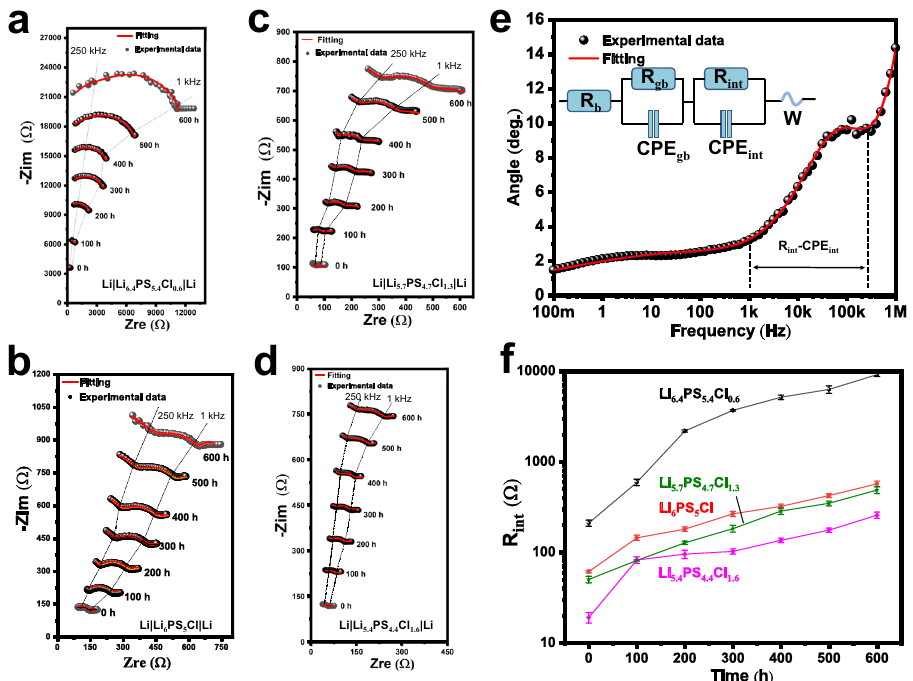
Fig. 2 Time-resolved EIS tested intermittently on the Li|Li 7 − x PS 6 − x Cl x |Li symmetric cells for 600 h at 24 °C. Evolution of the impedance signal in Nyquist plots for the samples of Cl-06 ( a ), Cl-10 ( b ), Cl-13 ( c ), Cl-16 ( d ). e Representation of the impedance signal (Cl-13 at 300 h) in a Bode plot. The inset displays the equivalent circuit diagram adopted for fi tting the Bode plot and the impedance spectra ( a – d ). f Interfacial layer resistance of Li|SE as a function of storage time.